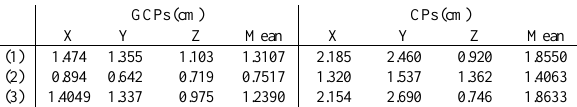
Table 2. RMS error on Ground Control Points (GCPs) and Control Points (CPs)